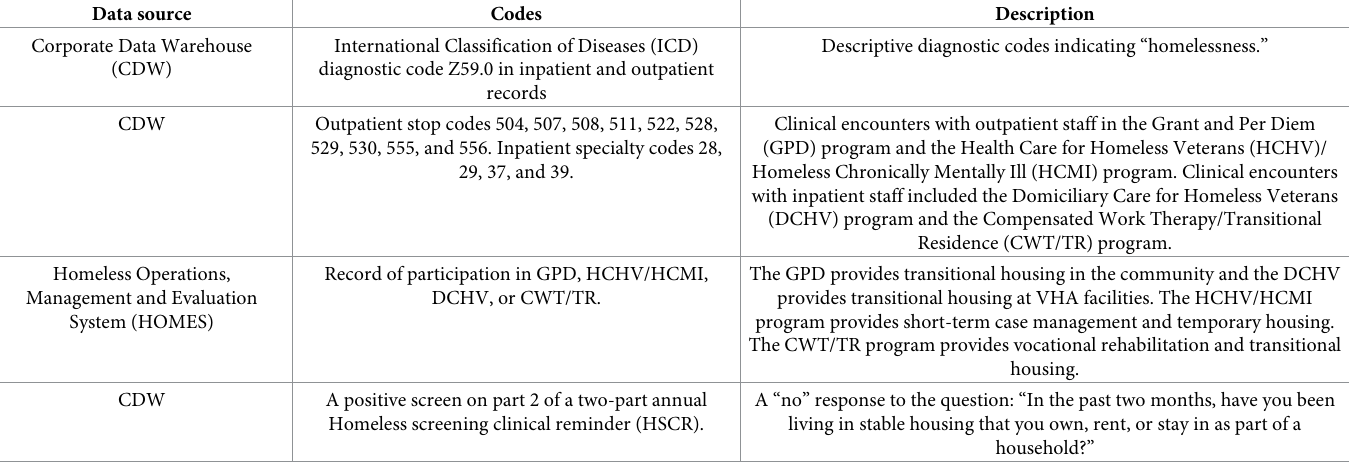
Table 2. Data sources and definitions for homelessness from the VA medical